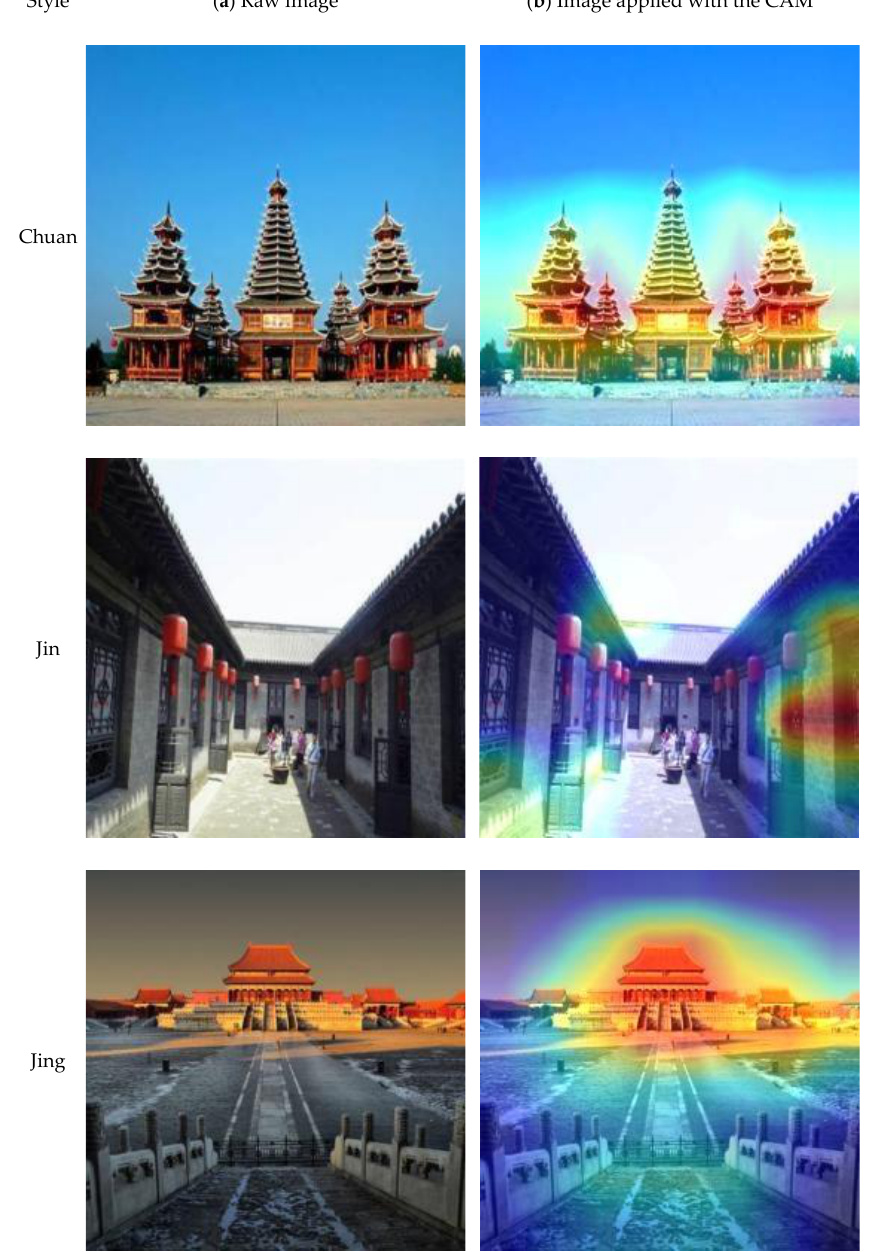
Figure 8. Interpreting the CNN classifier using the CAM visualization technique. ( a ) Raw image; ( b ) Image after applying the CAM visualization technique. Note that the deeper the yellow color in the images with CAM, the higher the influence on the final decision of the